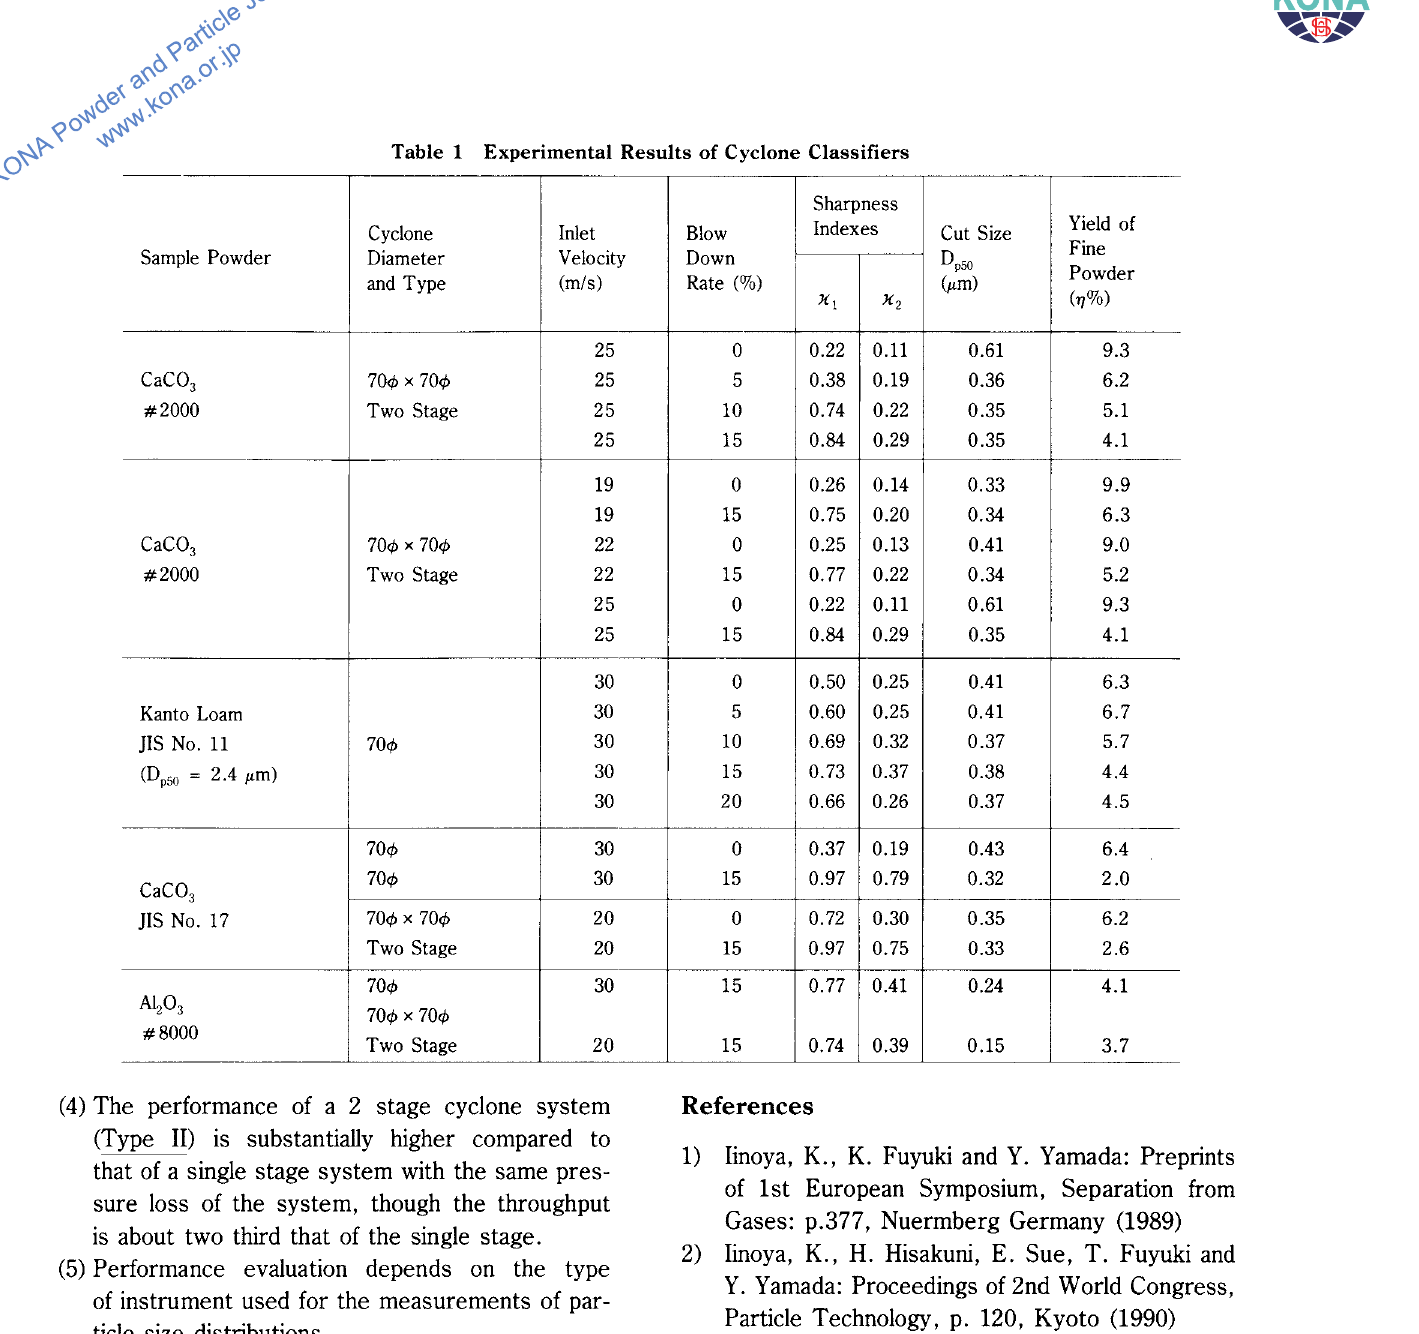
Table 1 Experimental Results of Cyclone